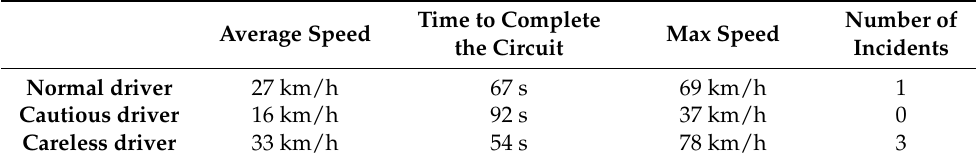
Table 4. Results of the tests with assistance from knowledge base and UAV. Time to Complete Average Speed the Circuit Normal